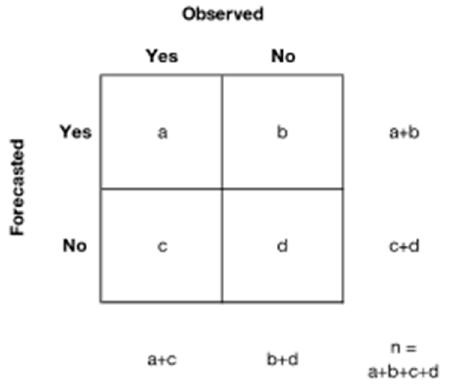
Figure 3. Contingency table used to calculate the categorical indices [30].